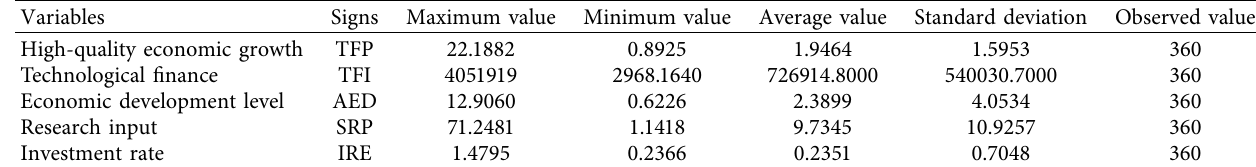
Table 3: Descriptive statistics of the variables.